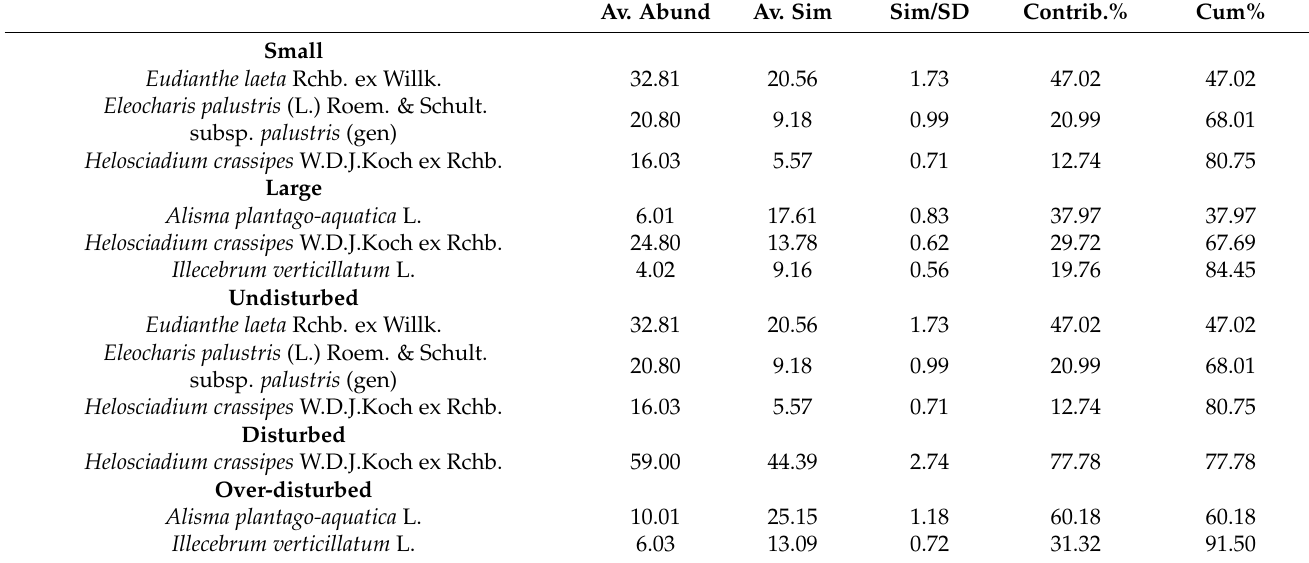
Table 2. SIMPER results for discriminant species throughout different size and disturbance levels. Av. Abund: average abundance; Av. Sim.: average Bray–Curtis similarity between all pairs of sites in the group; Sim./SD: ratio of the contribution to the standard deviation; Contrib.%: contribution to the total average similarity; Cum%: cumulative contribution to the total within-group similarity.